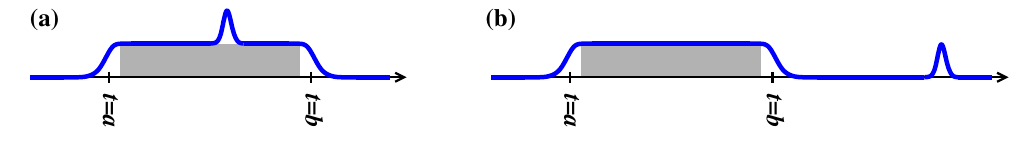
Figure 4 . Like figure 3 but showing cases where there are additional contributions to the sub-leading additive constant c that do not correspond to the boundaries of the logarithmic